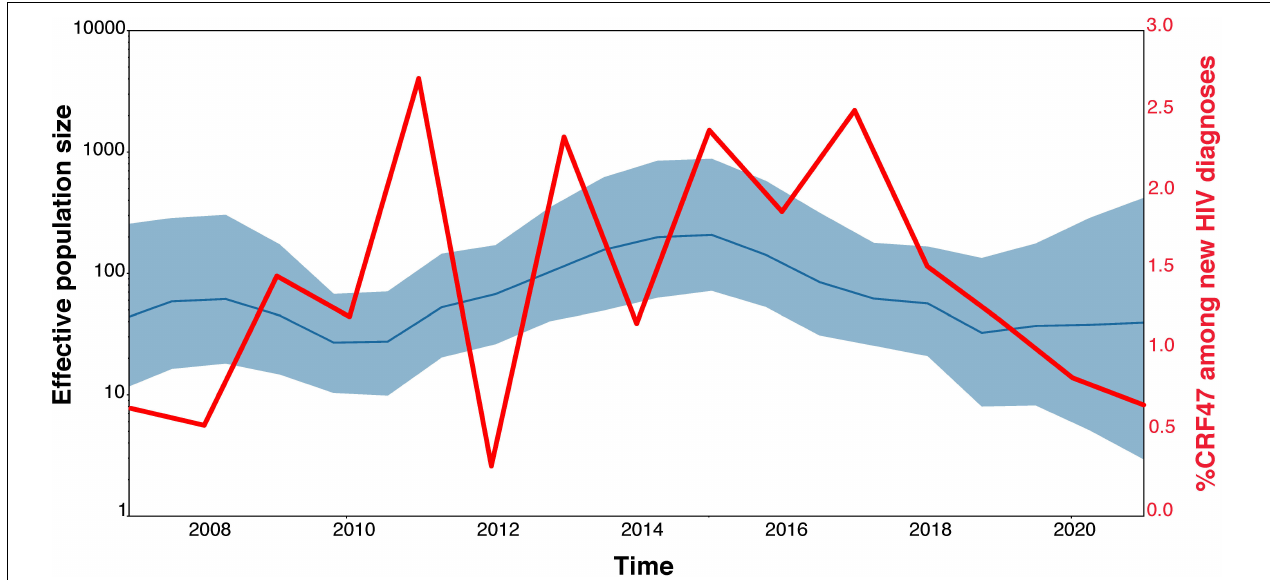
FIGURE 4 | Population dynamics of CRF47_BF in Spain. Bayesian Skygrid estimate of fluctuating population size by year compared with the actual proportion of new CRF47_BF samples collected in the study each year among new HIV-1 diagnoses.